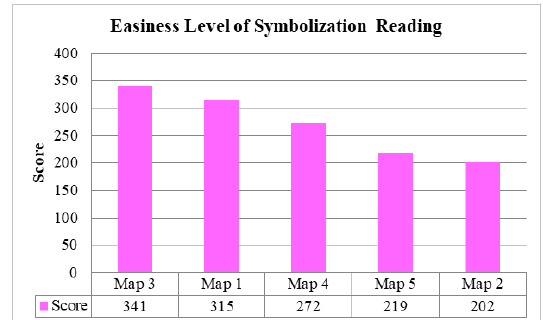
Figure 4.4 Easiness Level of Symbolization